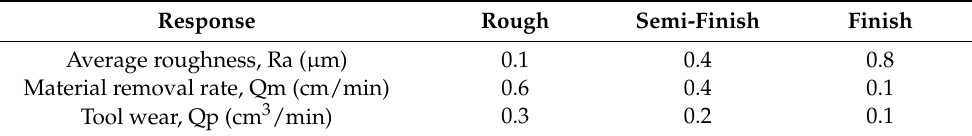
Table 2. Importance values used for each response and honing phase in the optimization.